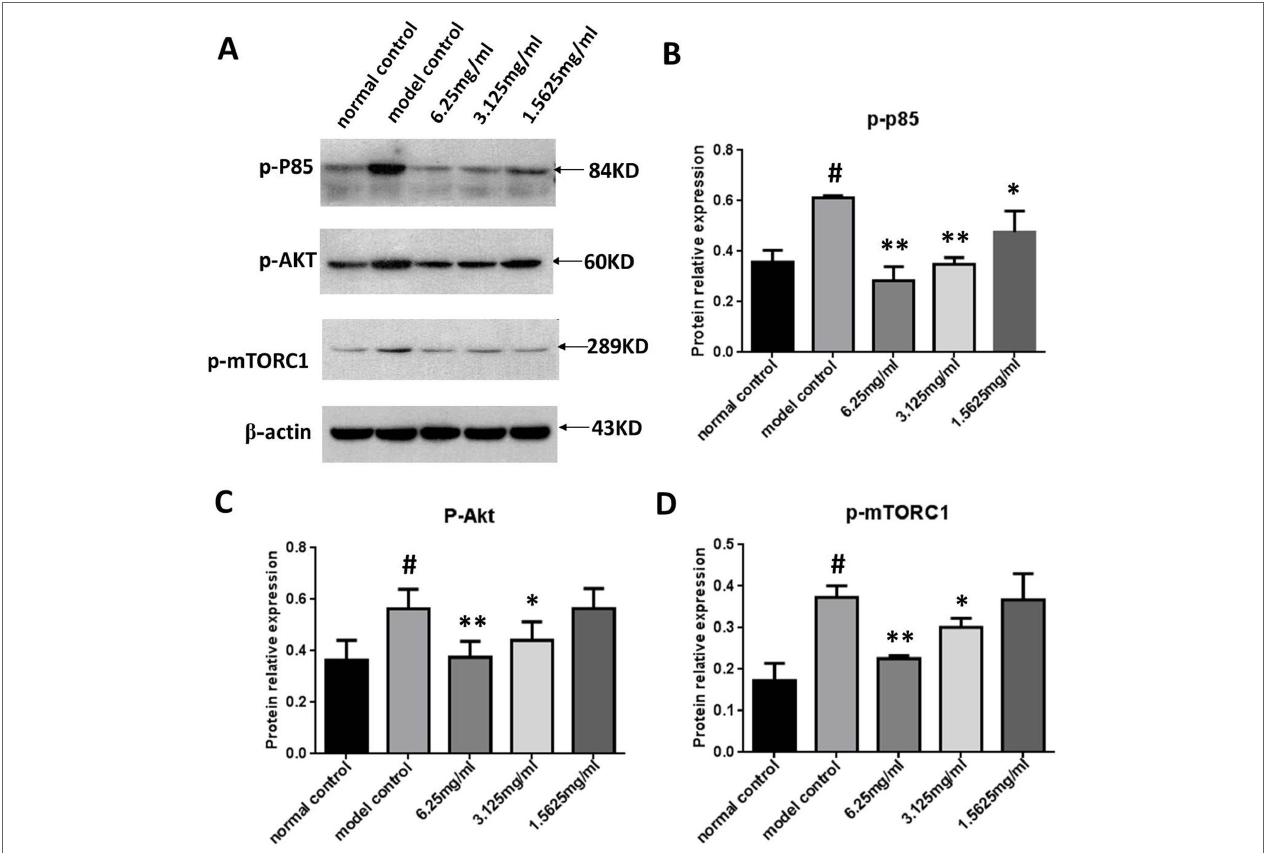
FIGURE 7 | Effect of SYDC on the PI3K/Akt/mTORC1 signaling pathway in RAW264.7 cells. (A) Representative images of Western blot showing the p-PI3K, p-Akt, and p-mTORC1 expression in RAW264.7 cells in the different groups. GAPDH was used as a loading control. (B) Densitometry values of the Western blot analysis of p-p85 expression were normalized to GAPDH expression and represented as relative intensity (n = 5). (C) Densitometry values of the Western blot analysis of p-Akt were normalized to GAPDH expression and represented as relative intensity (n = 5). (D) Densitometry values of the Western blot analysis of p-mTORC1 were normalized to GAPDH expression and represented as relative intensity (n = 5). # P < 0.01 vs. blank control group alone; * P < 0.01 vs. model control group alone, SYDC-H, high-SYDC (6.25 mg/ml), SYDC-M, middle-SYDC (3.125 mg/ml), and SYDC-L, low-SYDC (1.5625 mg/ml) (n = 3).